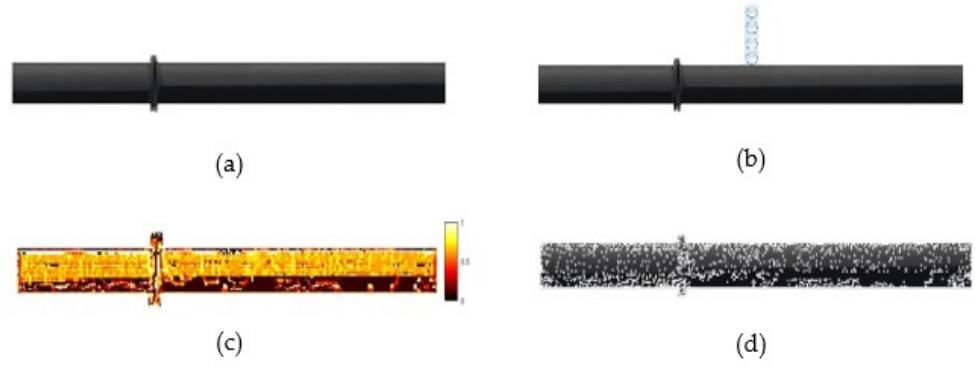
Figure 9. Surface discretization using the TEM model: ( a,b ) A pipeline image used in simulation; ( c ) LBP regions with scaled colors; ( d ) center of texture elements as scattering points.